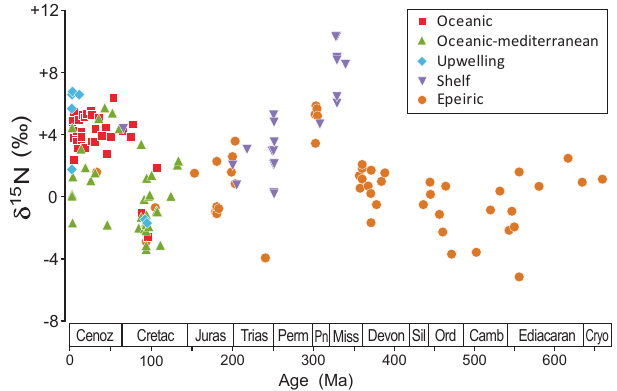
Fig. 5. δ 15 N sed as a function of depositional setting. For the Neogene, upwelling units are 1.3‰ enriched and oceanic- mediterranean units 3.0‰ depleted in 15 N on average relative to oceanic units. For units of any given age, note the generally lim- ited variation in δ 15 N sed among different setting types, relative to the larger variation in δ 15 N sed through time. For the Phanero- zoic asa whole, note the smooth δ 15 N sed transition in the mid- Mesozoic between entirely different setting types, i.e., epeiric and shelf in the Jurassic and earlier versus mainly oceanic and oceanic- mediterranean in the Cretaceous and